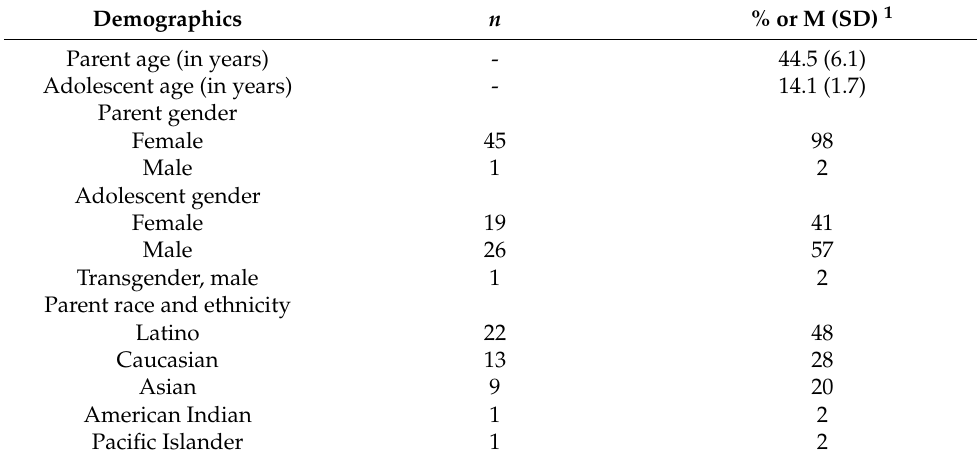
Table 3. Parent and Adolescent Dyad Demographics ( N =